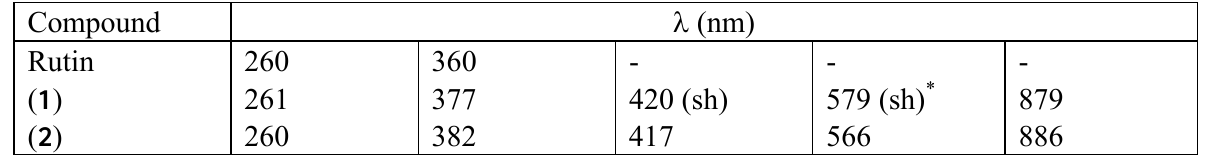
Table 2. Absorption maxima from UV-Vis spectra.